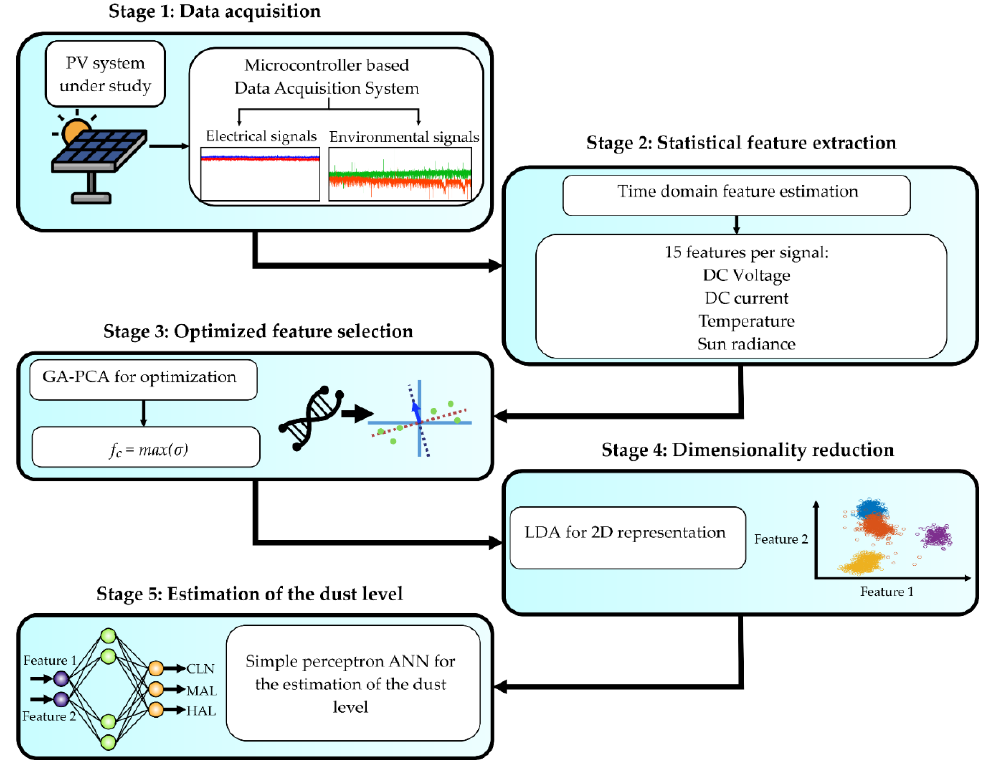
Figure 2. Step-by-step diagram of the proposed methodology.